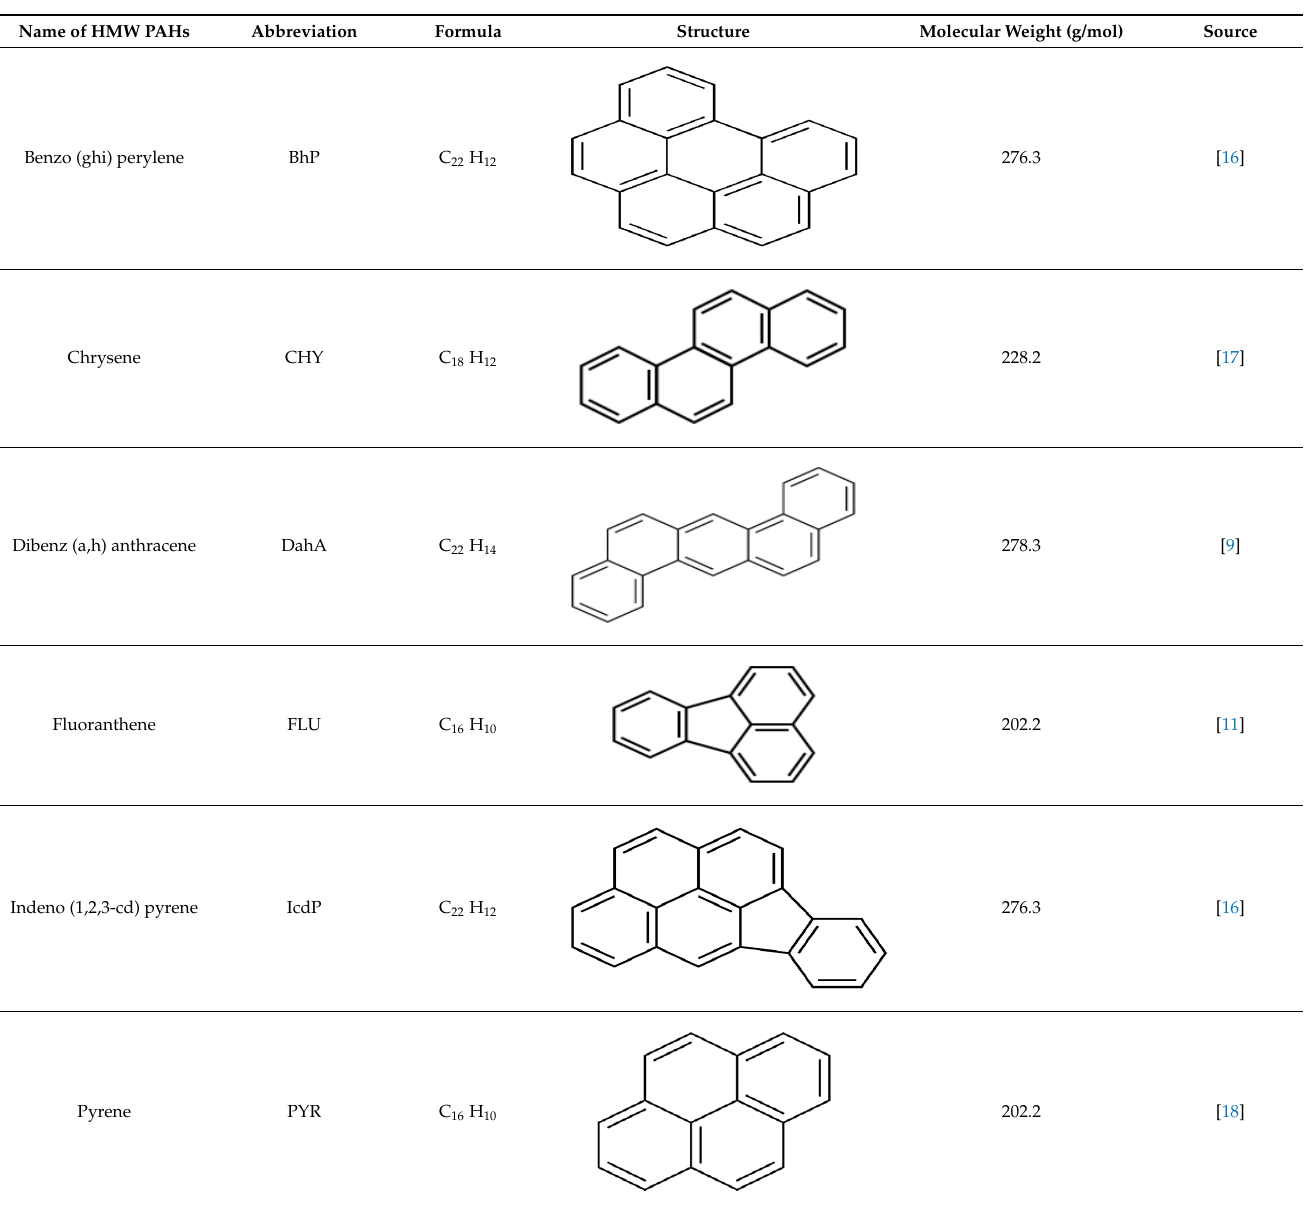
[8] Table 2. Types of HMW polycyclic aromatics hydrocarbons and their molecular structure. Name of HMW PAHs Abbreviation